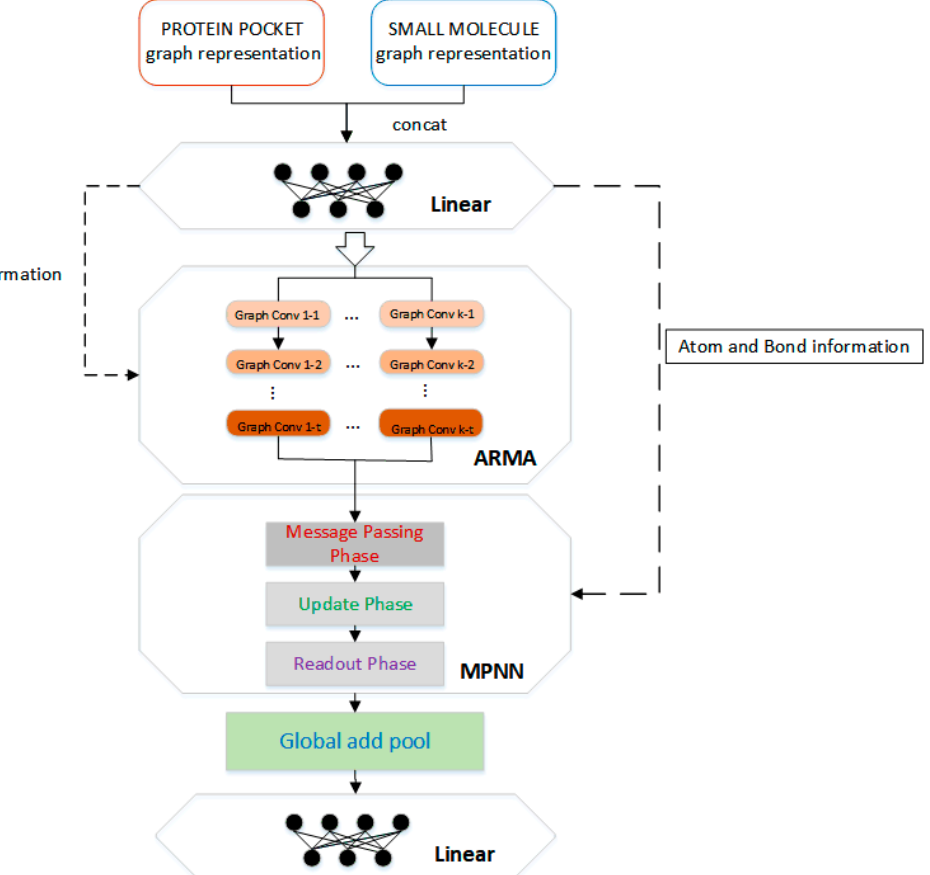
Figure 6. Schematic representation of the APMNet workflow.